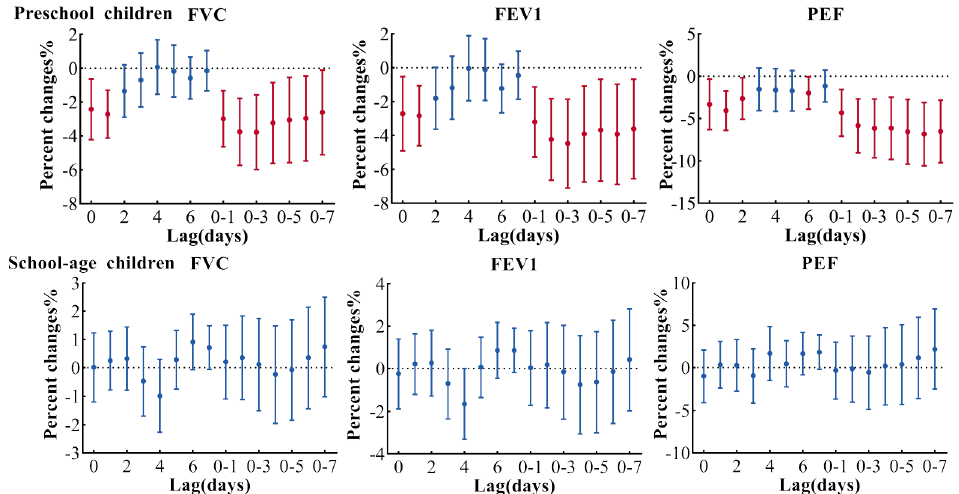
Figure 5. Association between lung function and PM 2.5 in age-stratified multi-pollution model (adjusted PM 2.5 + SO 2 + O 3 ). Preschool children: age < 6 years old; school-age children: age ≥ 6 years old. Estimates are adjusted for questionnaire information, relative humidity, temperature, BMI, sex, holiday, day of week and times of the measurement. FVC, forced vital capacity; FEV1, forced expiratory volume in 1 s; PEF, peak expiratory